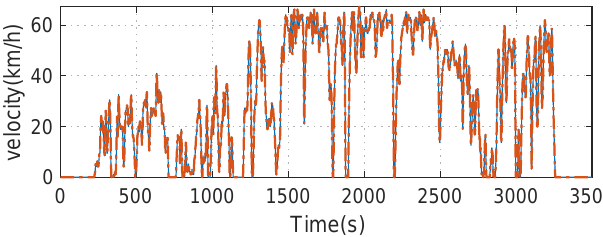
Figure 17. The actual and desired vehicle-speed trajectories.